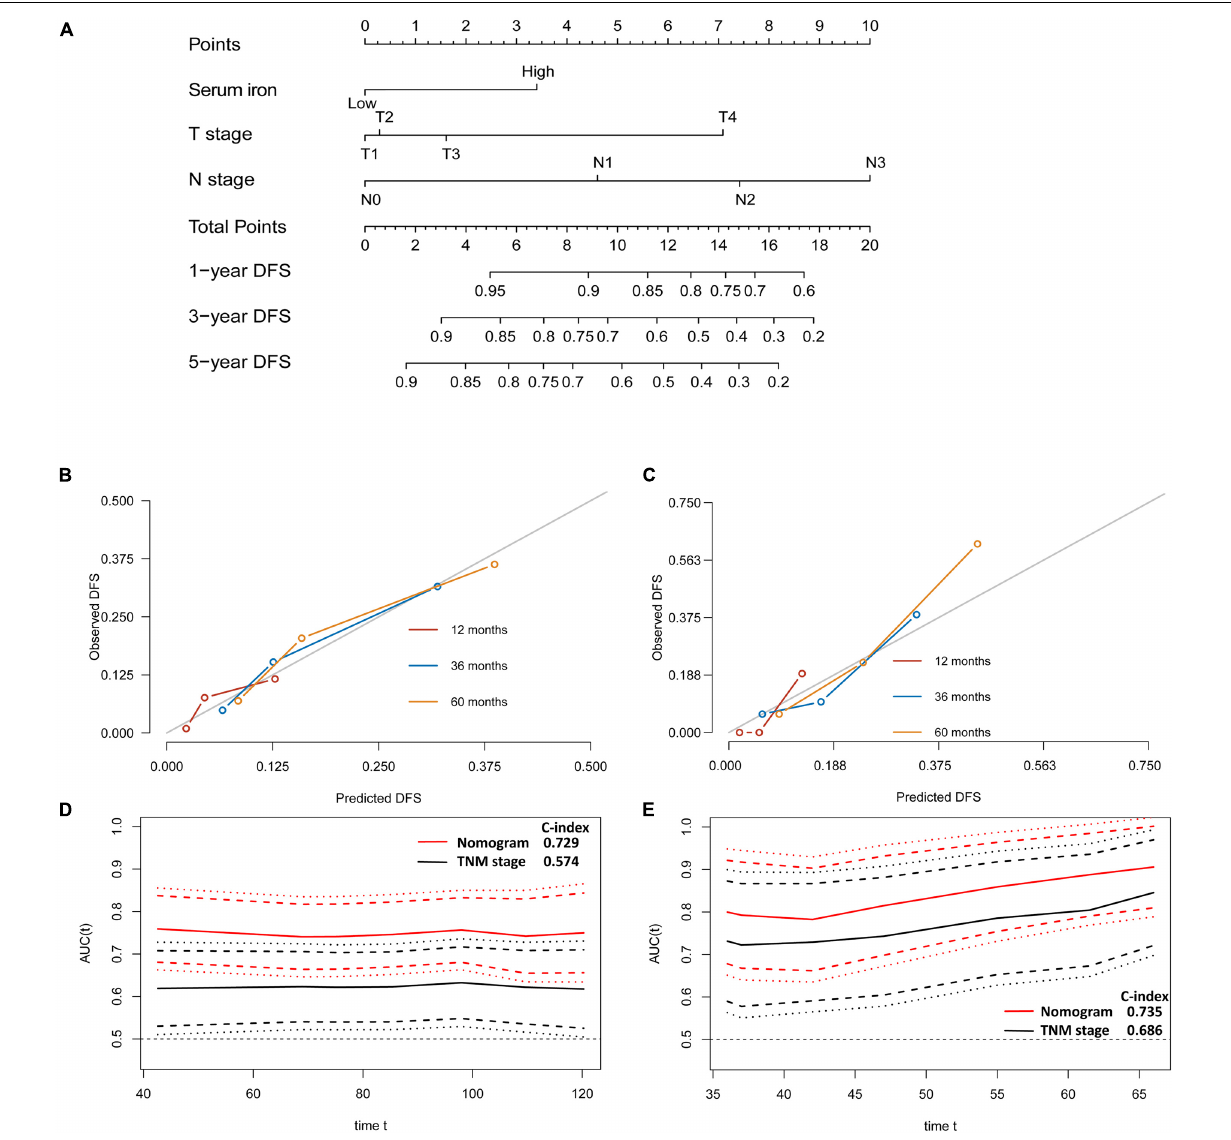
FIGURE 4 | Establishment and validation of a model for individualized prediction of disease-free survival (DFS). (A) Nomogram of this predictive model for patients with early-stage triple-negative breast cancer. (B) Calibration plots of 1 − , 3 − , and 5-year DFS predictions in the training cohort. (C) Calibration plots of 1 − , 3 − , and 5-year DFS predictions in the SYSUCC-001 validation cohort. (D) Time-dependent receiver operating characteristic (ROC) curves in the training cohort. (E) Time-dependent ROC curves in the SYSUCC-001